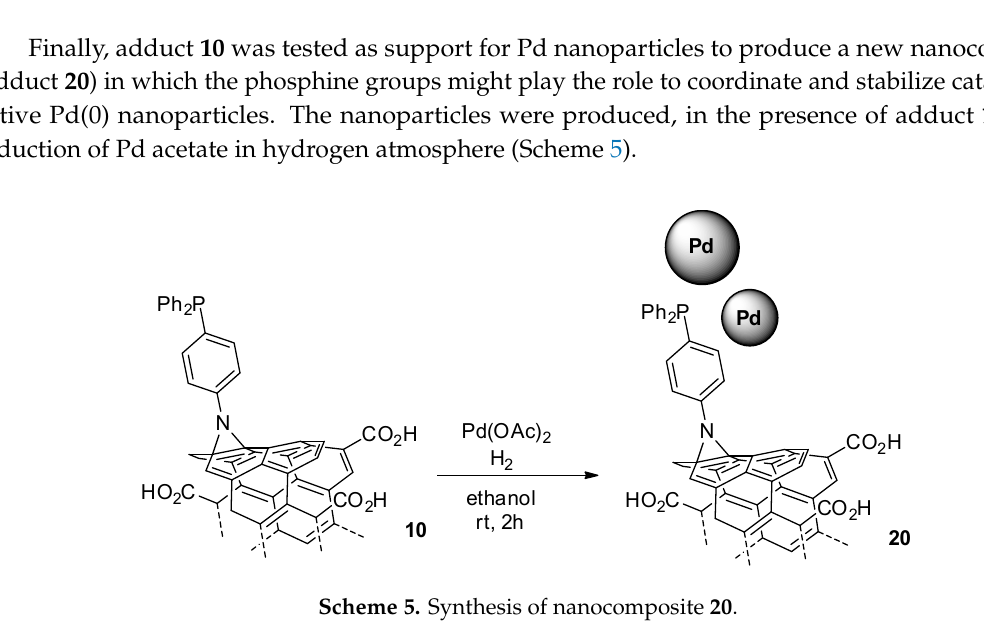
Table 5. Catalytic Staudinger ligation: yields of benzamide 19 over the different cycles. Entry Table 4. Catalytic Mitsunobu reaction: yields of benzoate 16 over the different cycles. Entry Catalyst